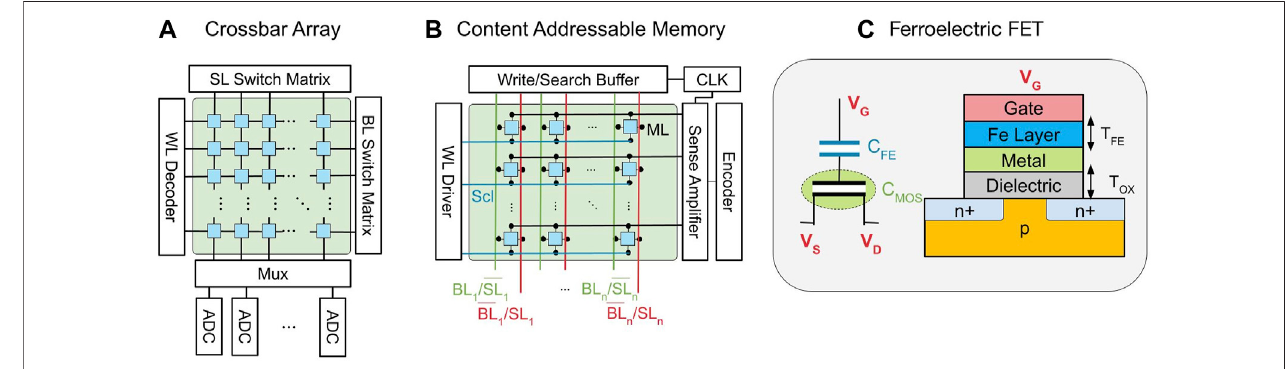
FIGURE 2 | (A) Crossbars are array-like circuit structures where each input is connected to every output typically by a resistor at their crosspoints. (B) CAMs can perform fast parallel searches in their memory. (C) FeFET devices are CMOS compatible devices that provide non-volatility, high density, and low power consumption.